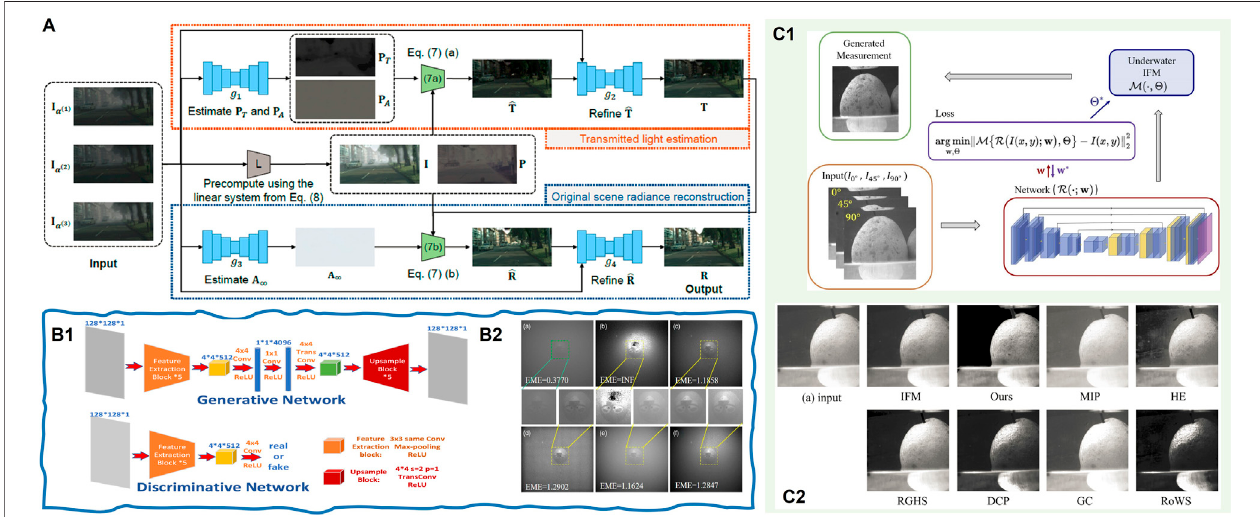
FIGURE 14 | (A) Schematic diagram of neural network structure proposed by Zhou et al. (reprint from MIT Press: Advances in Neural Information Processing Systems [117], copyright 2021). (B1) The architecture of the GAN-based polarization network and (B2) the recovered images (reprint from OSA: Applied Optics [118], copyright2021). (C1) Thearchitectureofuntrainednetworkin[119]and (C2) visualcomparisonamongdifferentde-scatteringmethods: ourmethod, i.e.,Zhu ’ smethod [119], IFM, MIP [120], HE [121], RGHS [122], DCP [3], GC [123], and RoWS [124] (reprint from OSA: Optics Express [119], copyright